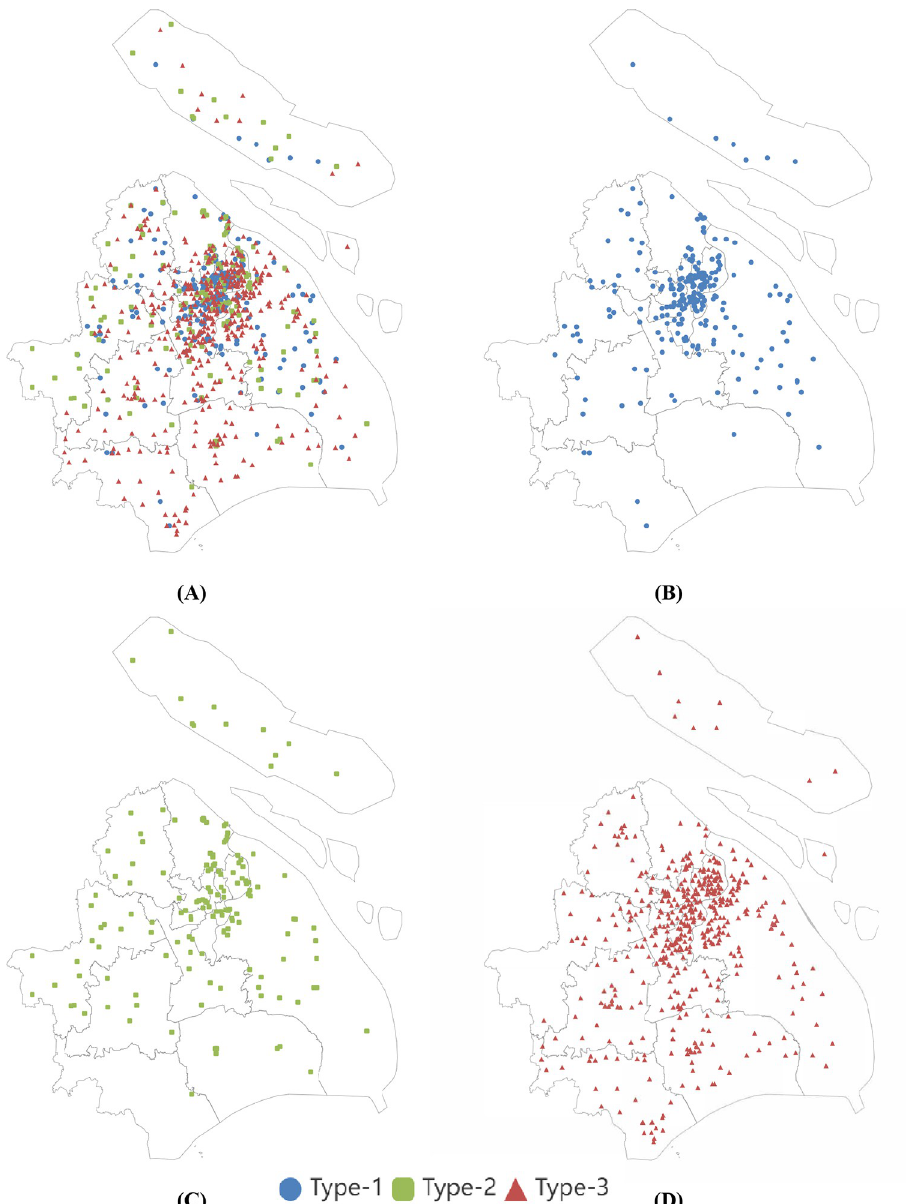
Fig 6. Geographical distribution of f PSSFC with three categories in urban districts in Shanghai by zoomed in to the scope of the urban area (distance � 15 kilometers to the Shanghai Municipal Peoples’ Government).